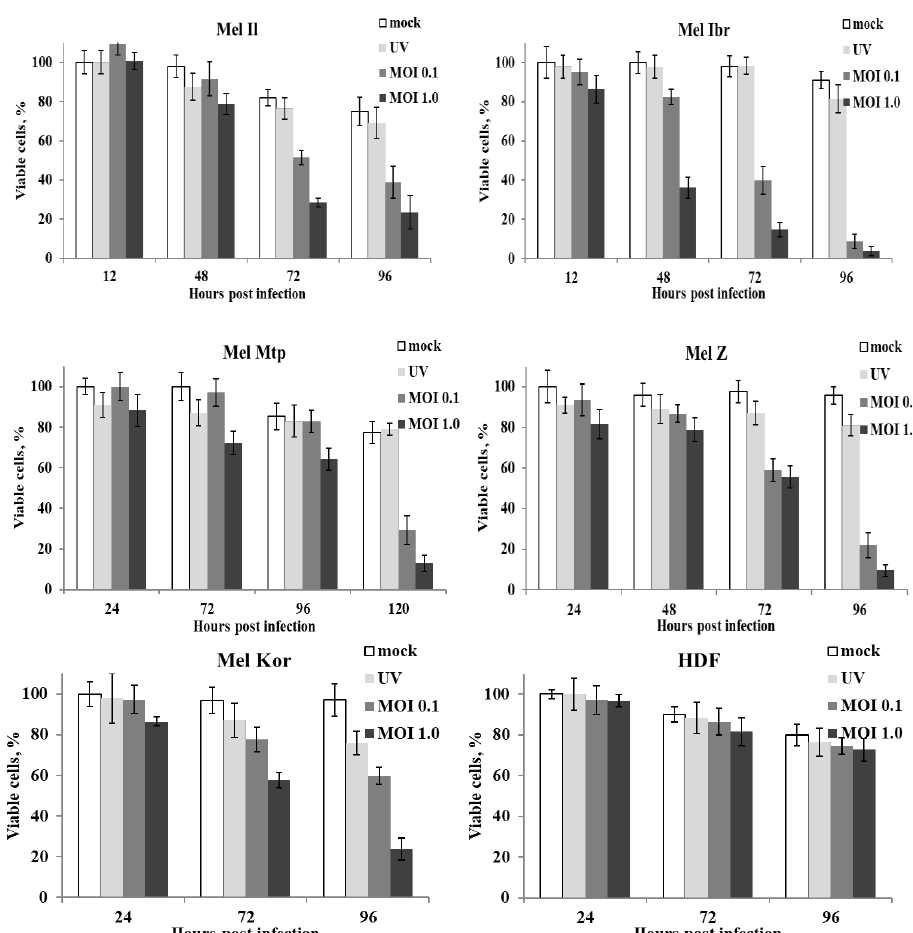
Figure 2. Oncolytic activity of MV strain L-16 against human melanoma cell lines. The viability of each cell line was measured after infection with MV at MOI of 1.0 (black) and 0.1 (gray) or UV-inactivated MV at MOI 1.0 (light gray) using the MTT assay. The data shown are mean results from three separate experiments; error bars indicate standard deviation (SD). The X-axis represents hours post infection, the Y is the percentage of viable cells for each time point relatively to the number of cells at 3 h post infection.